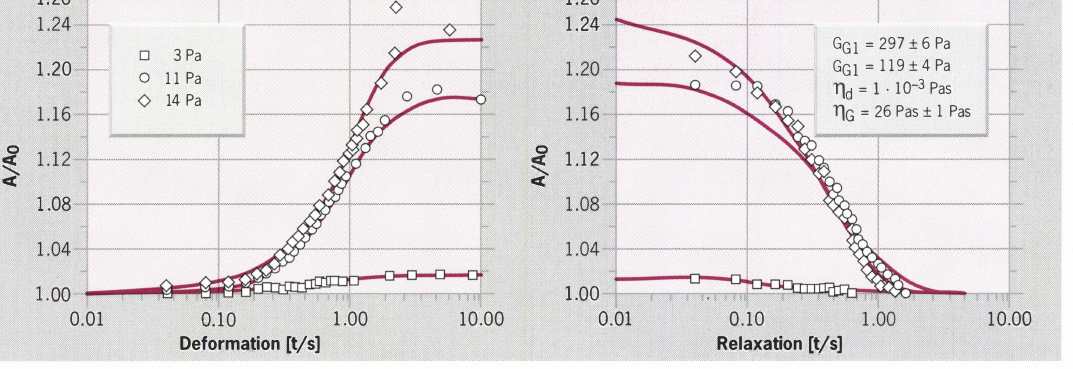
Fig. 8: A/A0(t} of droplets from Ll23 solution (x = 500 J.lm} in silicone oil (llk = 10.54 Pas}. Symbols: experimental data; line: calculated based on the model using equation (14} for constant strain